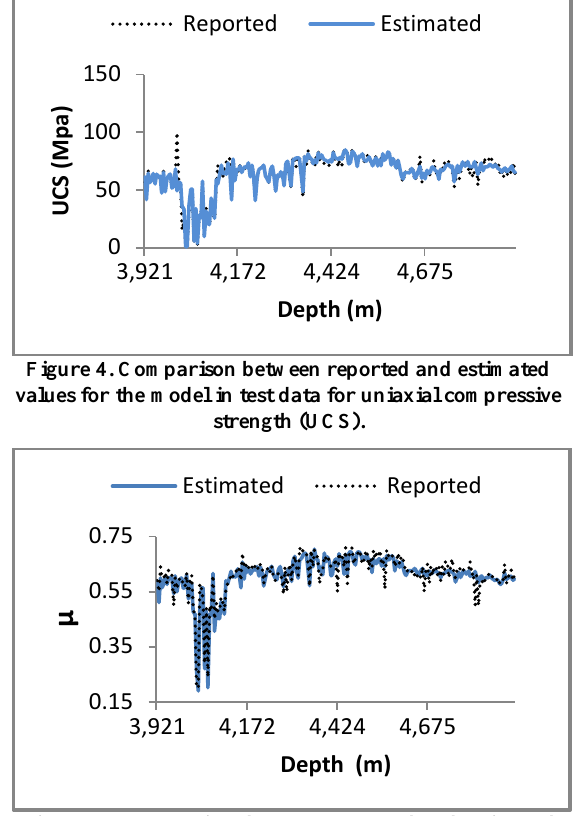
Figurer 5. Comparison between reported and estimated values for the model in the test data for internal friction coefficient (µ).